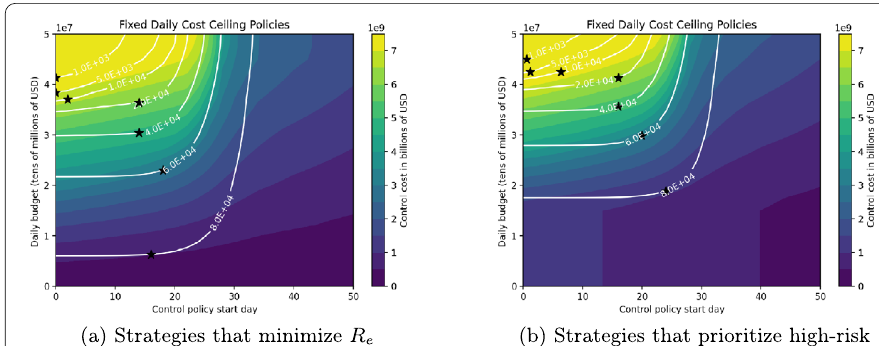
Figure 12 Daily budget and starting day for adjusting the number of deaths